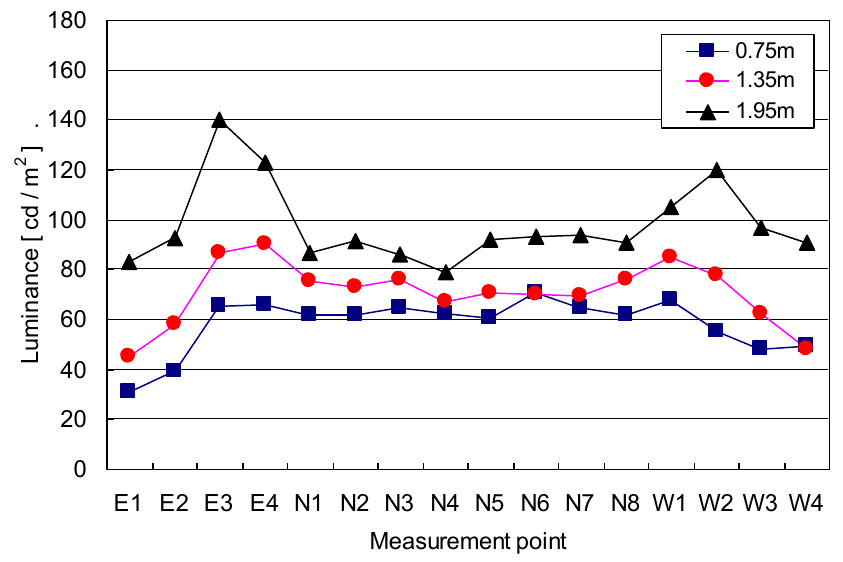
Figure 8. Variation of luminance on walls (750 lx